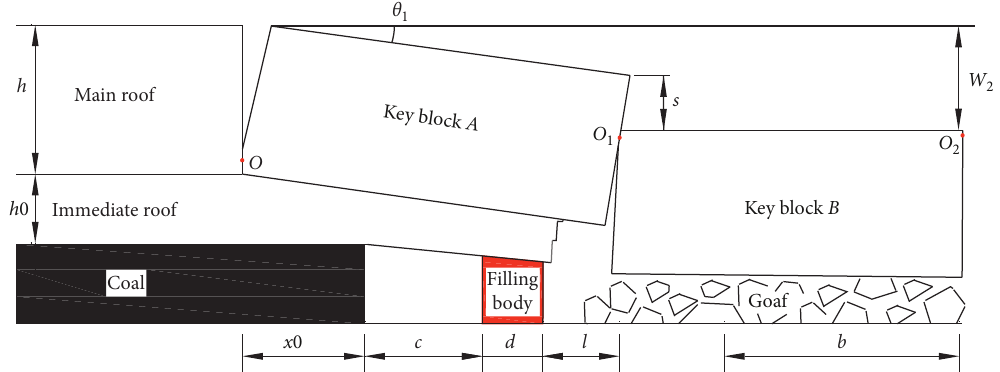
Figure 5: Structure model of short cantilever-step rock beam.